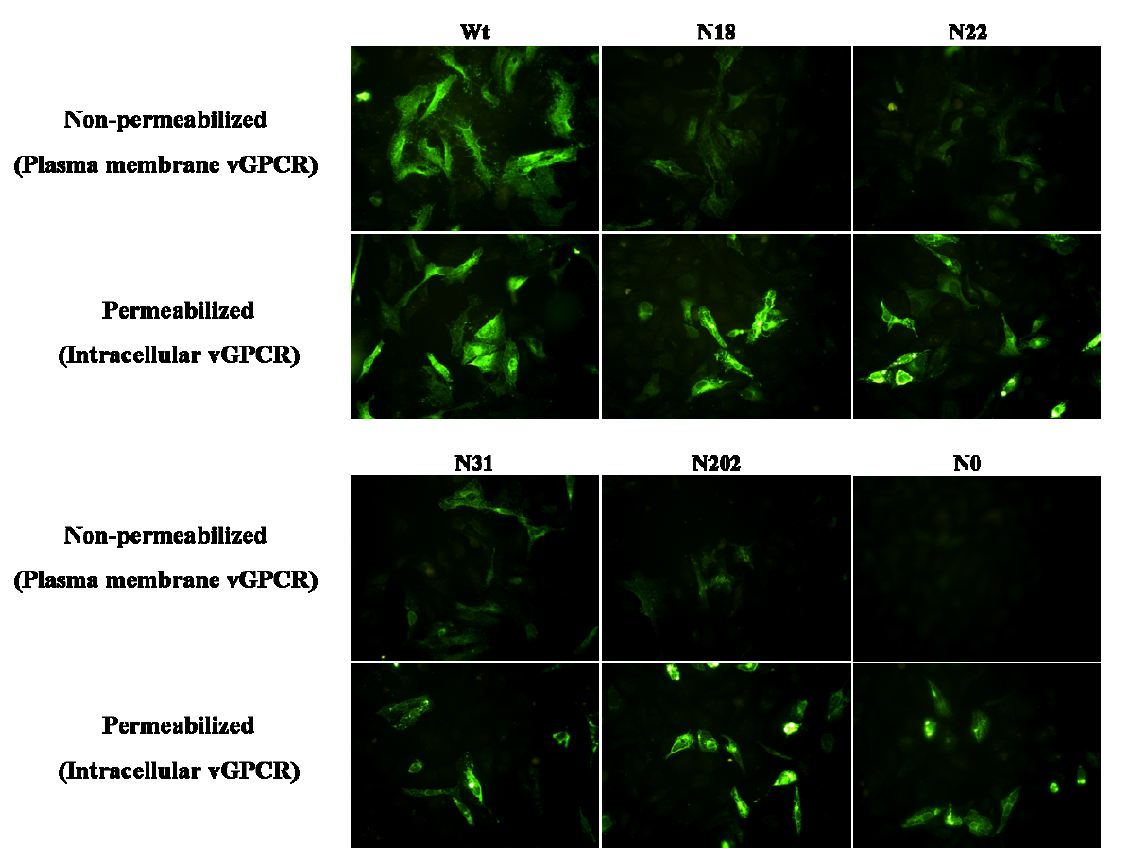
Figure 4. Glycosylation of vGPCR is crucial for its trafficking to plasma membrane. HeLa cells were transfected with plasmids expressing vGPCR or vGPCR glycosylation mutants (N18, N22, N31, N202 or N0) separately and the transfected cells were fixed at 24 h post transfection. The fixed cells were permeabilized (for detecting intracellular vGPCR) or not (for detecting vGPCR on the plasma membrane) and examined by immunoflurescence microscopy as described in methods. WT: FRT-TO-HA-vGPCR; N18, N22, N31, N202, N0: FRT-TO plasmids expressing corresponding vGPCR mutants with HA